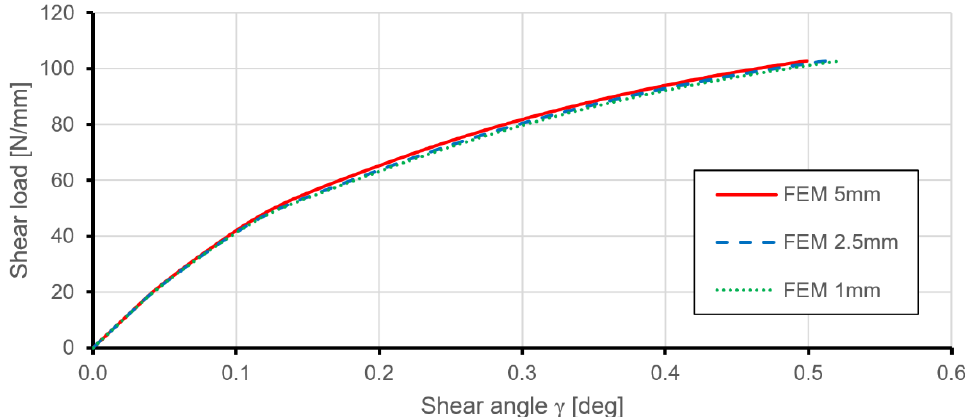
Figure 8. Comparison of results of shear load versus shear angle obtained from FEM for the stiffened plate in the convergence study.